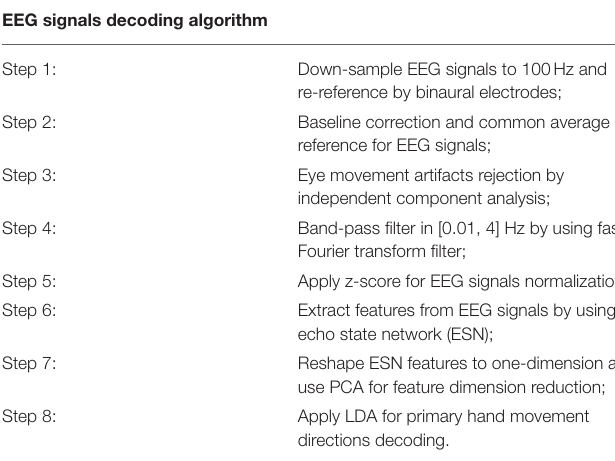
TABLE 1 | EEG signals decoding algorithm steps. EEG signals decoding